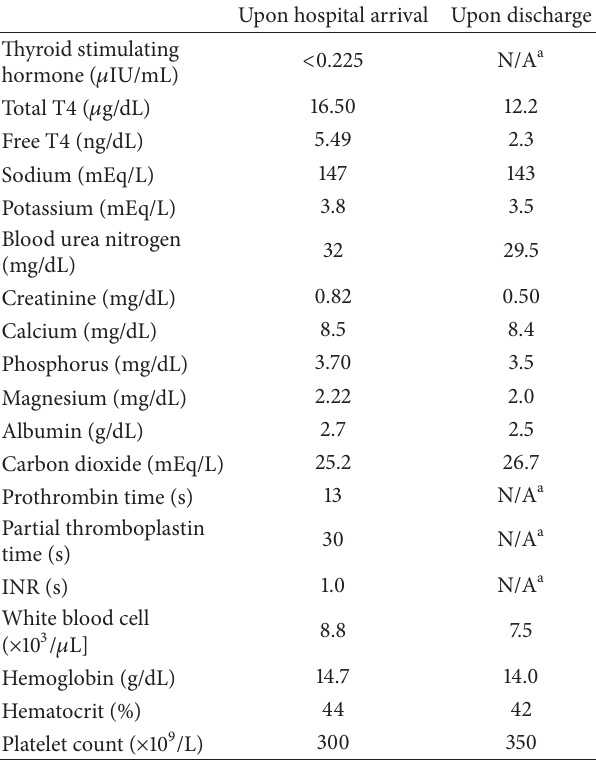
Table 1: Thyroid function tests and serum